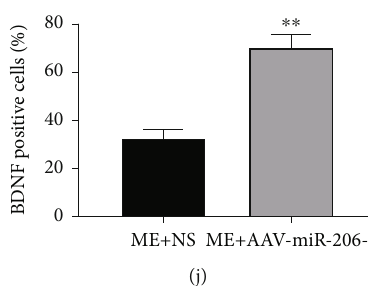
Figure 6: EA treatment following injection of a miR-206-3p inhibitor did not increase the expression of BDNF, BAX/Bcl-2, IL-6, and TNF- α after CCI. (a – c) The mRNA and protein expression of BDNF/GAPDH ( n = 5 ). (i, j) Staining for BDNF-positive (red) cells (scale bars: 100 μ m, 100x; 20 μ m, 400x) ( n = 5 ). (d – h) Representative western blots and quanti fi cation data of BAX/Bcl-2, IL-6/GAPDH, and TNF- α / GAPDH ( n = 5 ). Bars indicate the mean ± SD . ∗∗ p < 0 : 01 versus ME+NS group.